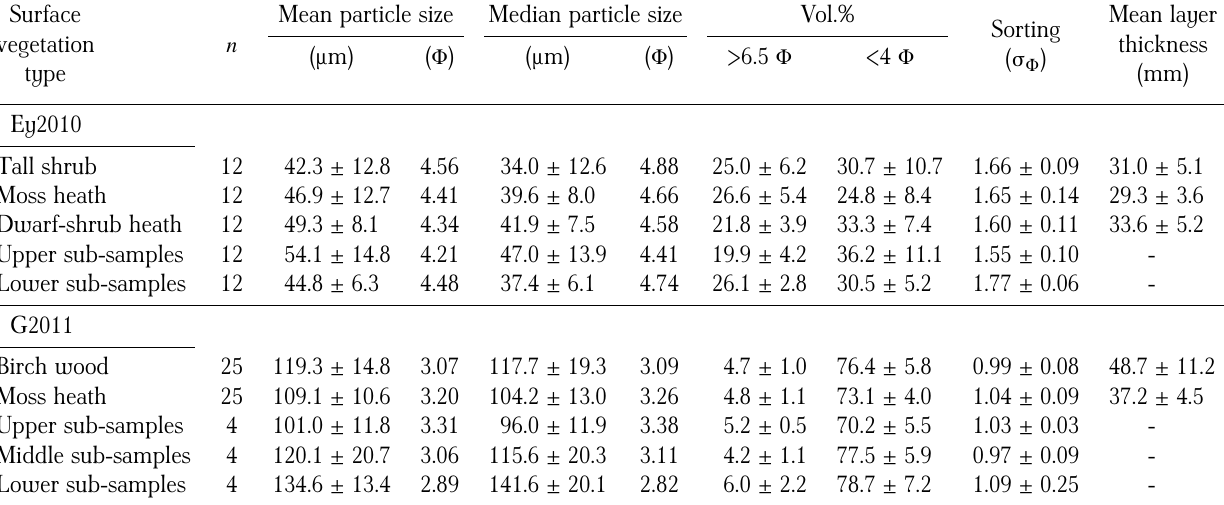
Table 3: Summary of key metrics for the Ey2010 tephra layer at Langanes and the G2011 tephra layer at Fossdalur, split by vegetation cover and portion of layer ( ± indicates range within 1 standard deviation). Note that vol.% >6.5 Φ is used as a measure of extremely fine ash (PM ) content, whilst vol.% <4 Φ is used as a measure of coarse ash content. According to the 10 interpretation scheme of Blott and Pye [2001], the closer the sorting coefficient ( σ ) is to 0, the better sorted the tephra Φ